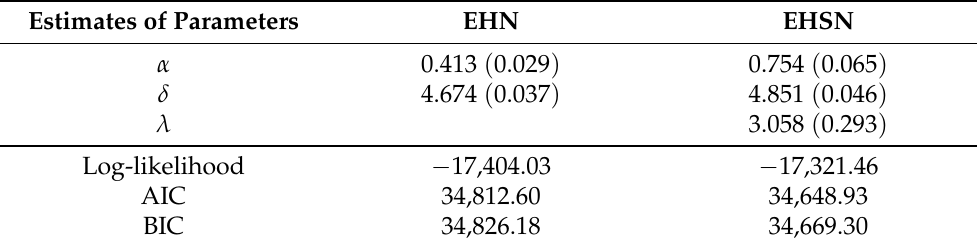
Figure 6. qqplots for Speed of Wind dataset: ( a ) EHN model, ( b ) EHSN model. Table 3. Estimated parameters in the EHN and EHSN